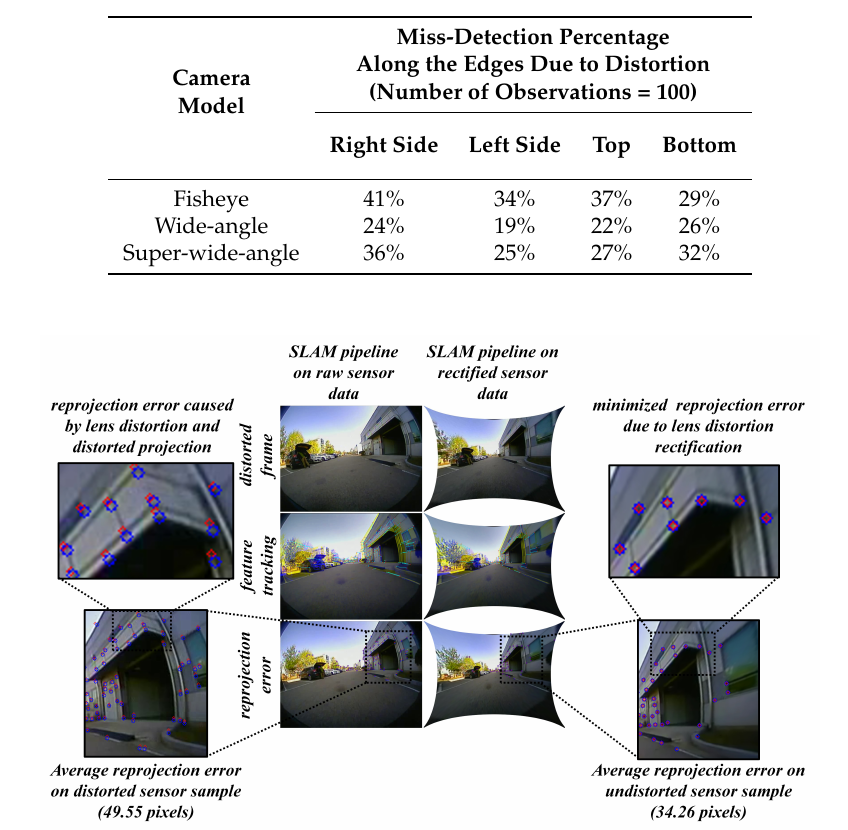
Figure 20. Auto-parking scenario on rear fisheye camera: Real-time visual SLAM pipeline on lens distortion rectified sensor